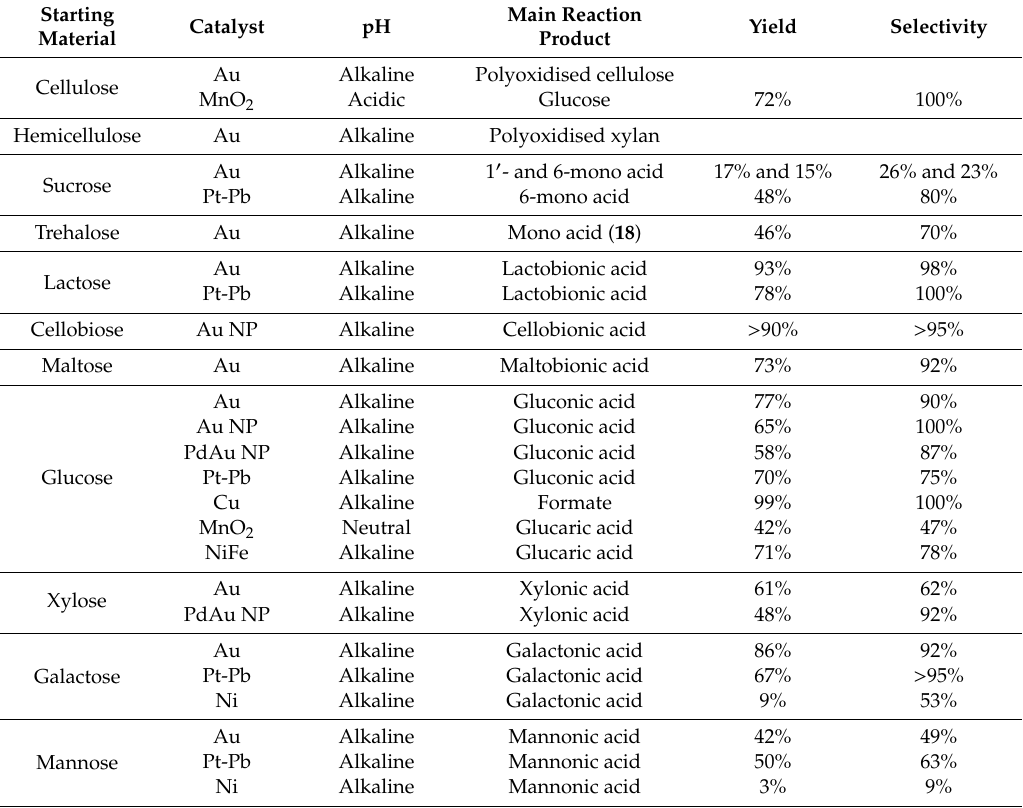
Table 8. Summary of the direct electro-oxidation of